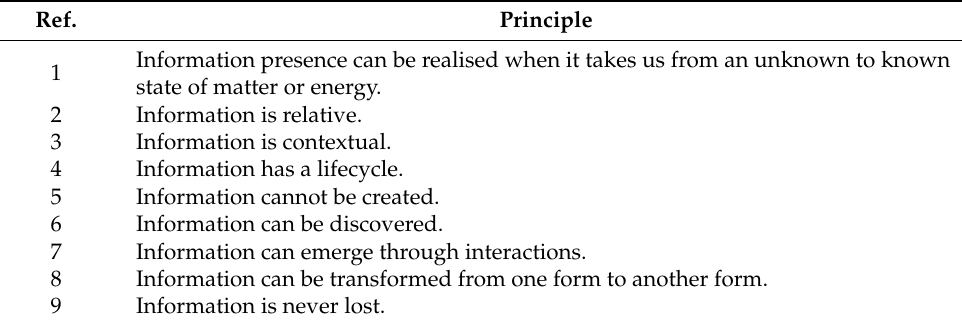
Table 2. Theory of information trilogy—generic information principles (based on [17]).